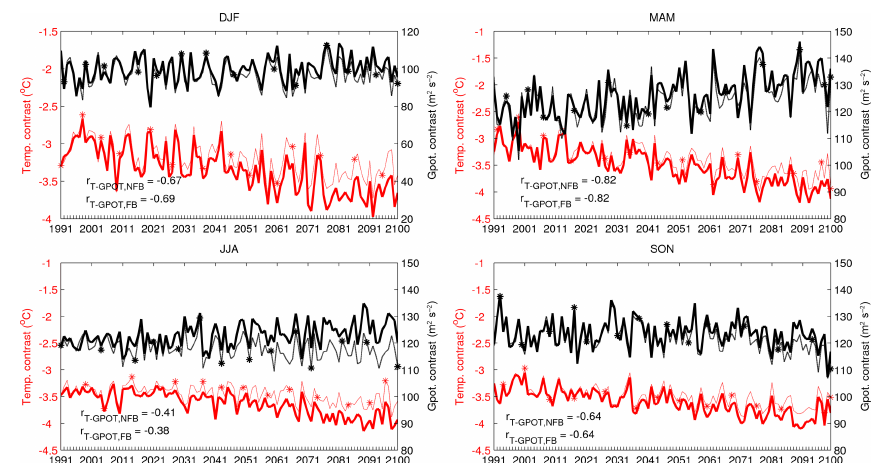
Figure A6. Annual changes in atmospheric ocean-land temperature contrast ( ∇ T ) and geopotential contrast ( ∇ ϕ ) in time series for four seasons, represented by the mean contrast at the three pressure levels 850, 925 and 975hPa (ocean minus land) within the domain 15 ◦ N– 15 ◦ S, 24 ◦ W–20 ◦ E (see the inset in the panel for JJA in Fig. 5). Correlation coefficient ( r ) between atmospheric temperature contrast ( ∇ T ) and geopotential contrast ( ∇ ϕ ) are computed based on the de-trended annual time-series values for both FB (thick lines) and NFB (thin lines with asterisks) simulations. Changes between FB and NFB are significant at 95% confidence level for the whole time period. Note the different y axis for